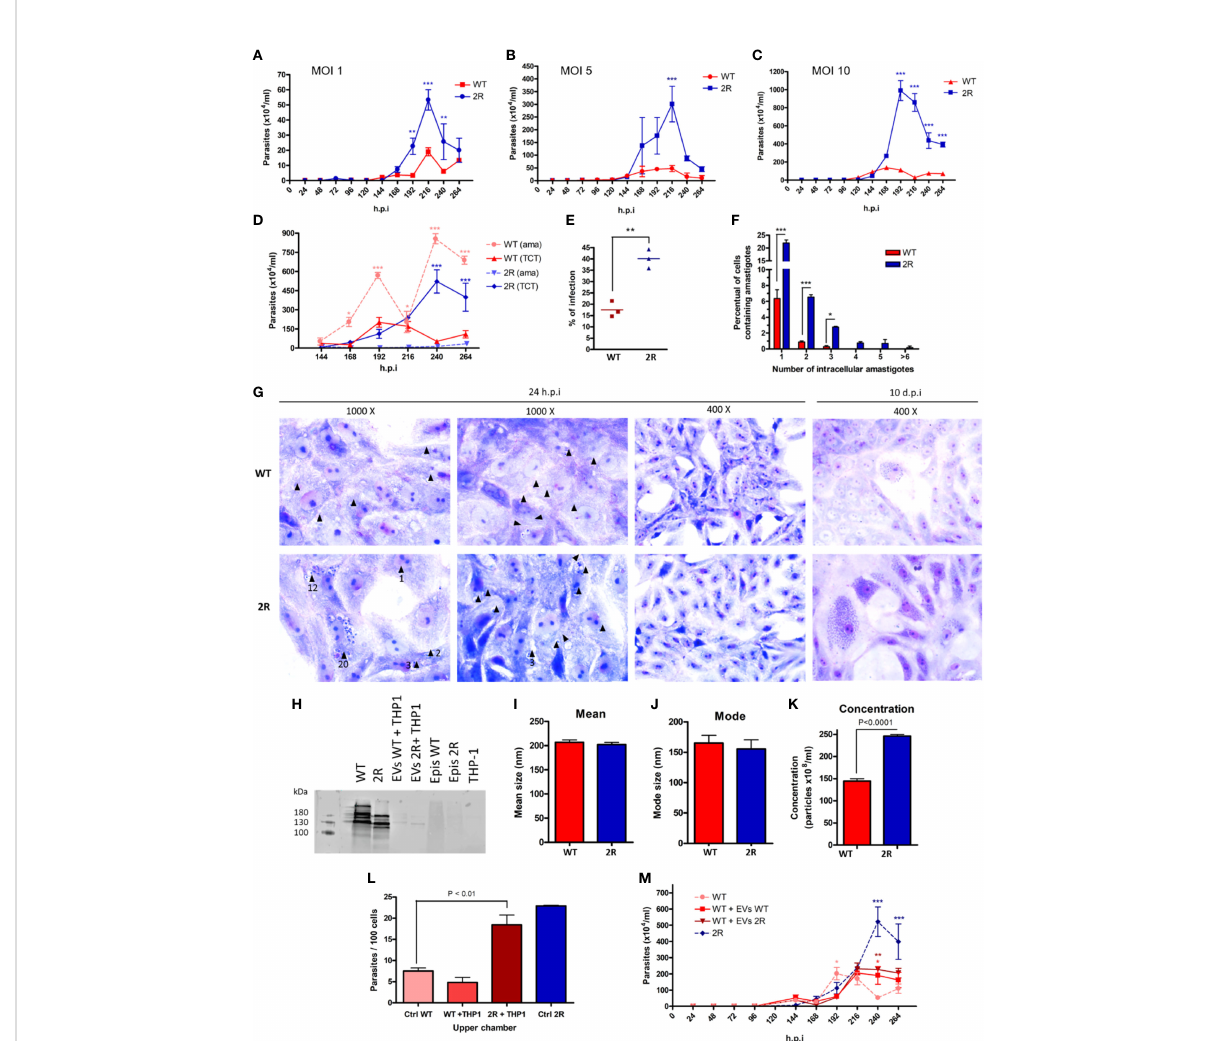
FIGURE 4 Parasite count in the supernatant after infection of Vero cells with TCTs at MOIs of 1 (A) , 5 (B) , and 10 (C) . (D) Comparison between the release of extracellular amastigotes (ama) and TCTs in the supernatant of cells infected at an MOI of 10. (E) Percentage of infected Vero cells after 24 h of infection with TCTs and another 24 h of incubation (MOI of 5). (F) Intracellular amastigotes counting 24 h.p.i. (MOI of 5). (G) Micrographs of Vero cells infected by TCT WT or 2R 24 h.p.i. (left panels) or 10 d.p.i. (last right panel) stained by Giemsa. Black arrows indicate the presence of amastigotes, and the numbers below the arrows indicate the amount of amastigotes (if present). After 10 days, the infection of Vero cells by WT TCTs (upper panel) has few cells with a large amount of amastigotes when compared with 2R TCTs (lower panel). (H) Analysis of the expression of trans-sialidases in TCTs of WT and 2R using antibody Mab 39 (bands ranging between 120 and 220 kDa). Samples analyzed: TCT WT (lane 1), TCT 2R (lane 2), 11 m g EV TCT WT with THP-1 (lane 3), 11 m g EV TCT 2R with THP-1 (lane 4), epimastigotes WT (lane 5), epimastigotes 2R (lane 6), and THP-1 (lane 7). (I, J) Mean and mode size of EVs derived from the interaction of TCTs with THP-1 in a 5 to 1 ratio (parasites to cells). (K) Concentration of EVs released from the interaction of TCTs with THP-1 in a 5 to 1 ratio (parasites to cells). (L) Invasion rates of WT TCTs to Vero cells during Transwell assay. The x -axis labels indicate what was placed in the upper chamber of the Transwell insert. “ Ctrl WT ” refers to the infection of WT parasites in only media. (M) Release of TCTs in the supernatant of infected cells at an MOI of 10 in the presence of 30 µg of EVs during the fi rst 24 h of infection. * P<0.05. ** P<0.01. ***